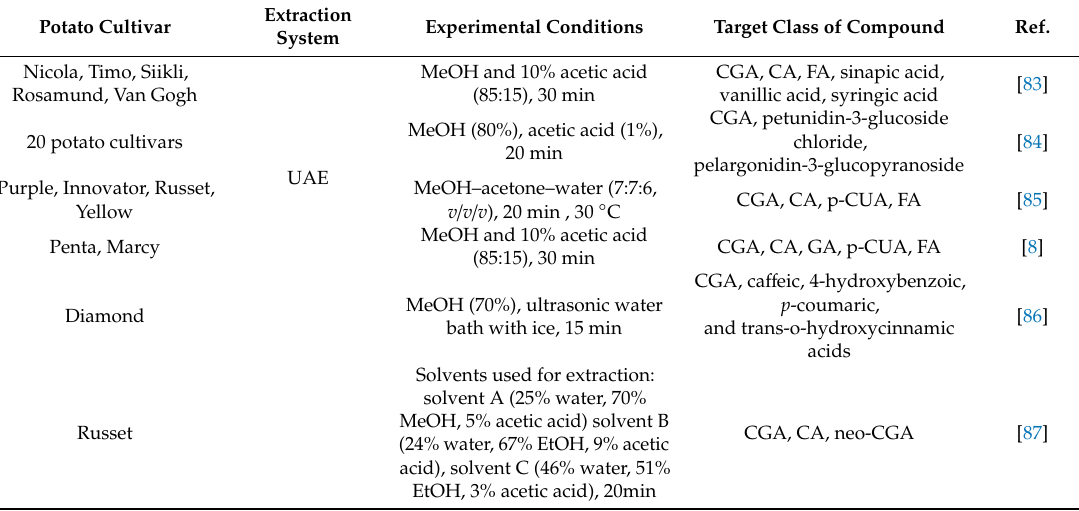
Table 4. Non-conventional extraction methods for phenolic compounds in